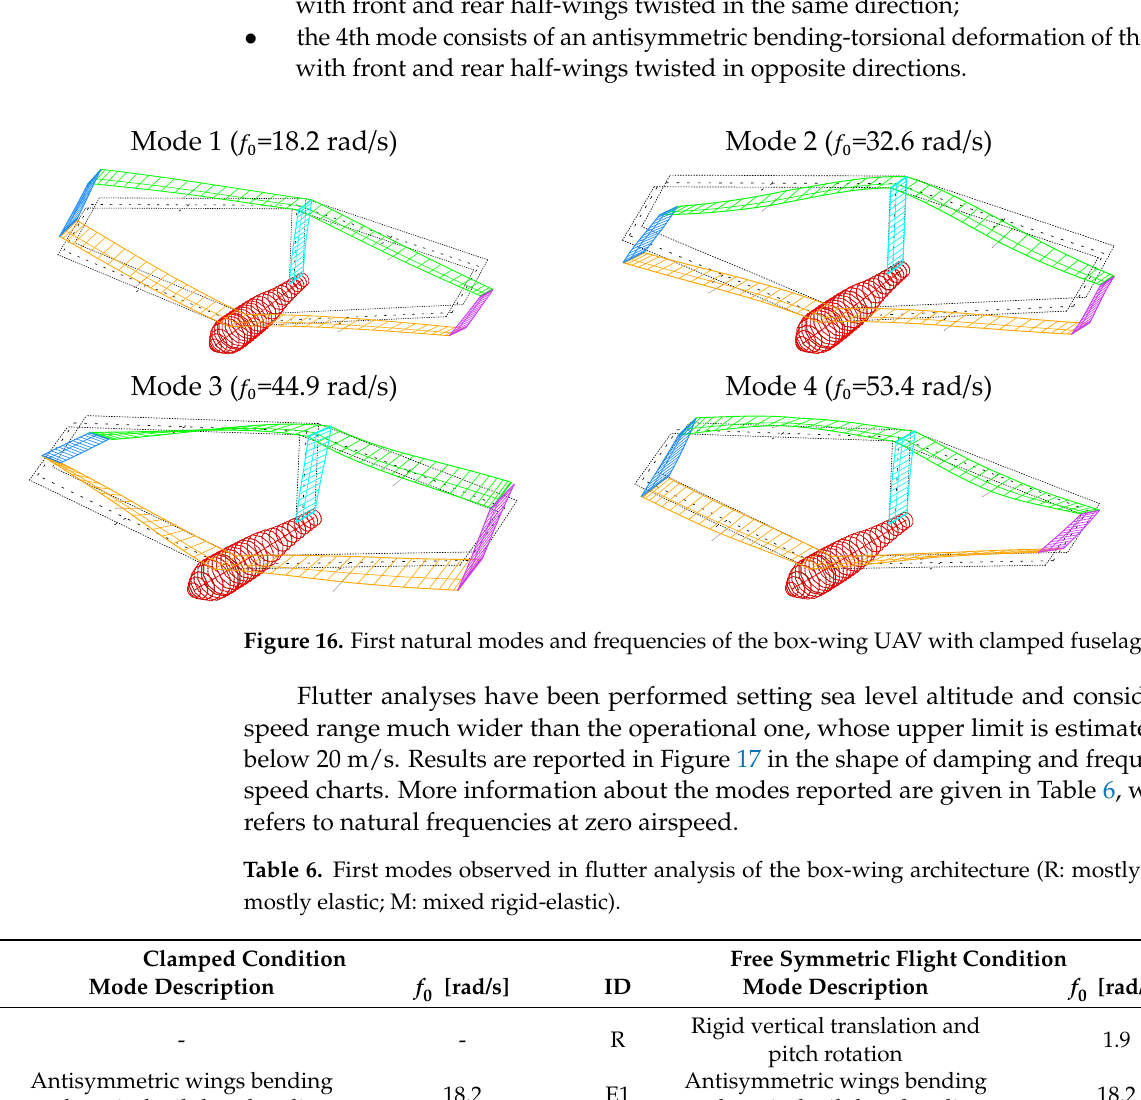
Table 6. First modes observed in flutter analysis of the box-wing architecture (R: mostly rigid; E: mostly elastic; M: mixed